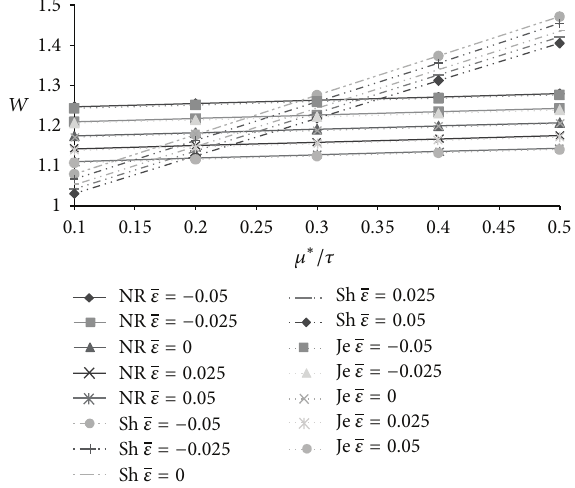
Figure 3: Variation of load carrying capacity with respect to 𝜇 ∗ /𝜏 and 𝜀 .